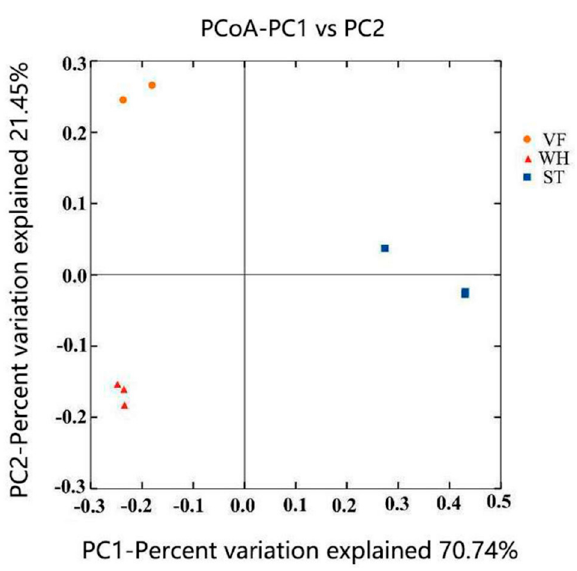
Figure 4. Principal coordinate analysis (PCoA) of the microbial community in VF, WH, and ST, based on the weighted UniFrac distance matrix.